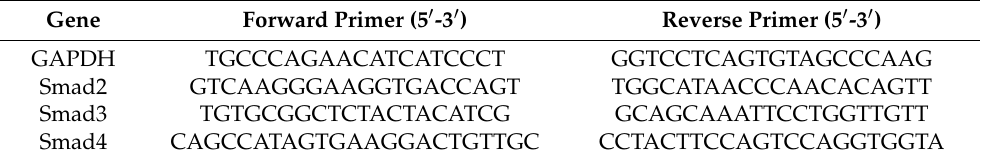
Table 1. Sequences of primers used in real-time polymerase chain reaction (Real-time PCR).